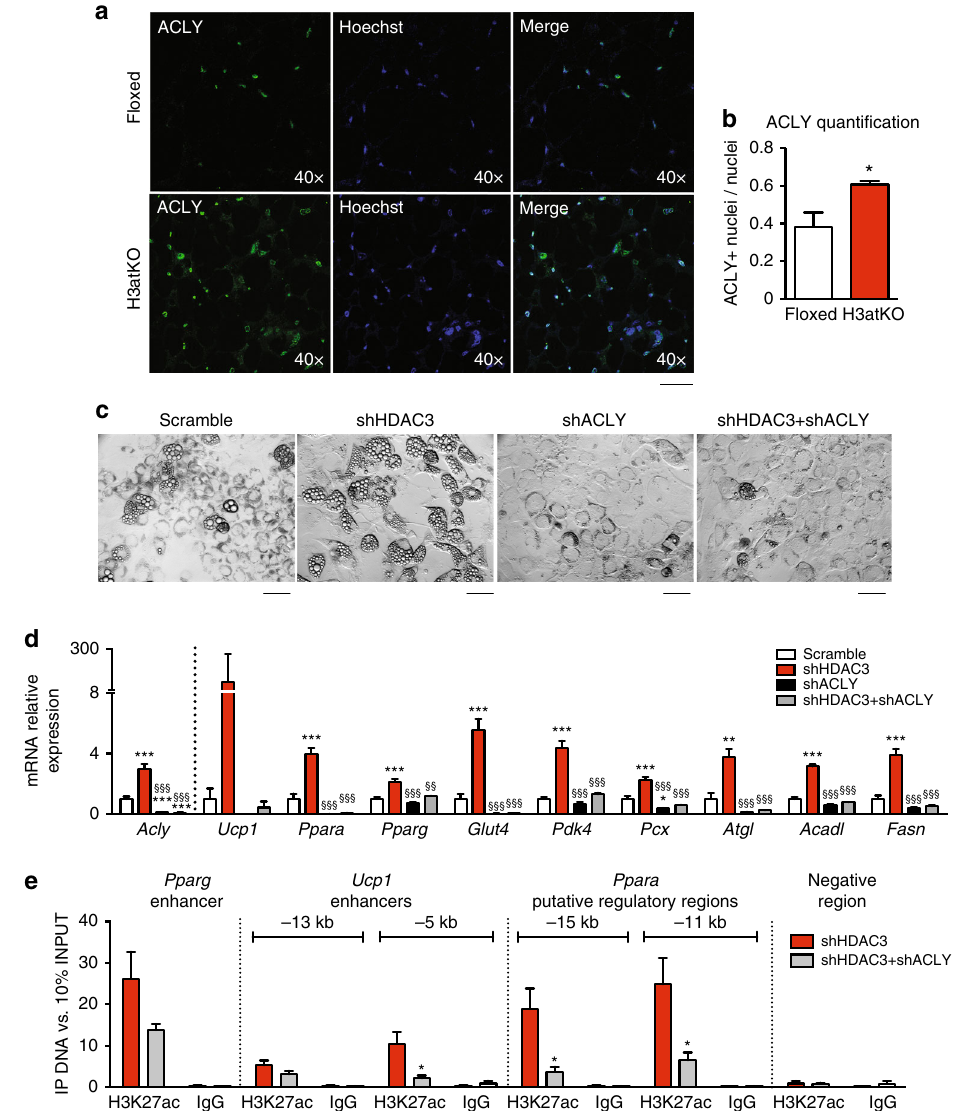
Fig. 6 ACLY is required for the establishment of H3atKO phenotype. a , b Immuno fl uorescence staining and quanti fi cation of ACLY, showing nuclear localization in Hdac3 knock out mice fed LFD ( n = 3 per group), scale bar is 40 μ m; c Morphology of cells infected with adenovirus expressing shRNA targeted to Hdac3 (shHDAC3), to Acly (shACLY) or both (shHDAC3 + shACLY) or to a scrambled control shRNA (scramble), scale bar is 50 μ m; d Gene expression analysis in knock down cells ( n = 3 per group); e H3K27ac ChIP analysis in knock down cells ( n = 6 per group). Data are presented as mean ± SEM. Statistical analysis: One way ANOVA, Tukey as post hoc test, * p < 0.05, ** p < 0.01, *** p < 0.001 vs. scramble, §§ p < 0.01, §§§ p <